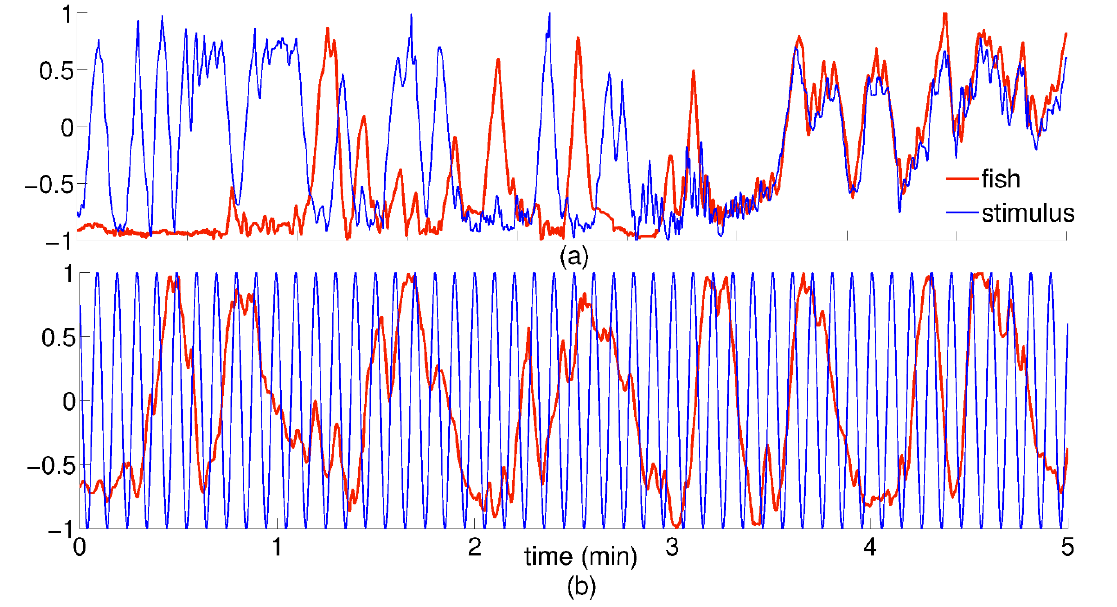
Figure 8 . Sample tank-wide positions of focal fish and stimuli (conspecific and replica) in ethorobotics experiments on social behavior of zebrafish. (a) Normalized tank-wide positions for a fish (red) interacting with a conspecific (blue); for this sample, TE fish→stimulus = 0.615 bits and TE stimulus→fish = 0.524 bits , where “stimulus” is the conspecific. (b) Sample tank-wide positions for a fish (red) interacting with a replica (blue); for this sample, TE fish→stimulus = 0.357 bits and TE stimulus→fish = 0.638 bits, where “stimulus” is the replica. [Reproduced from (Butail et al.,